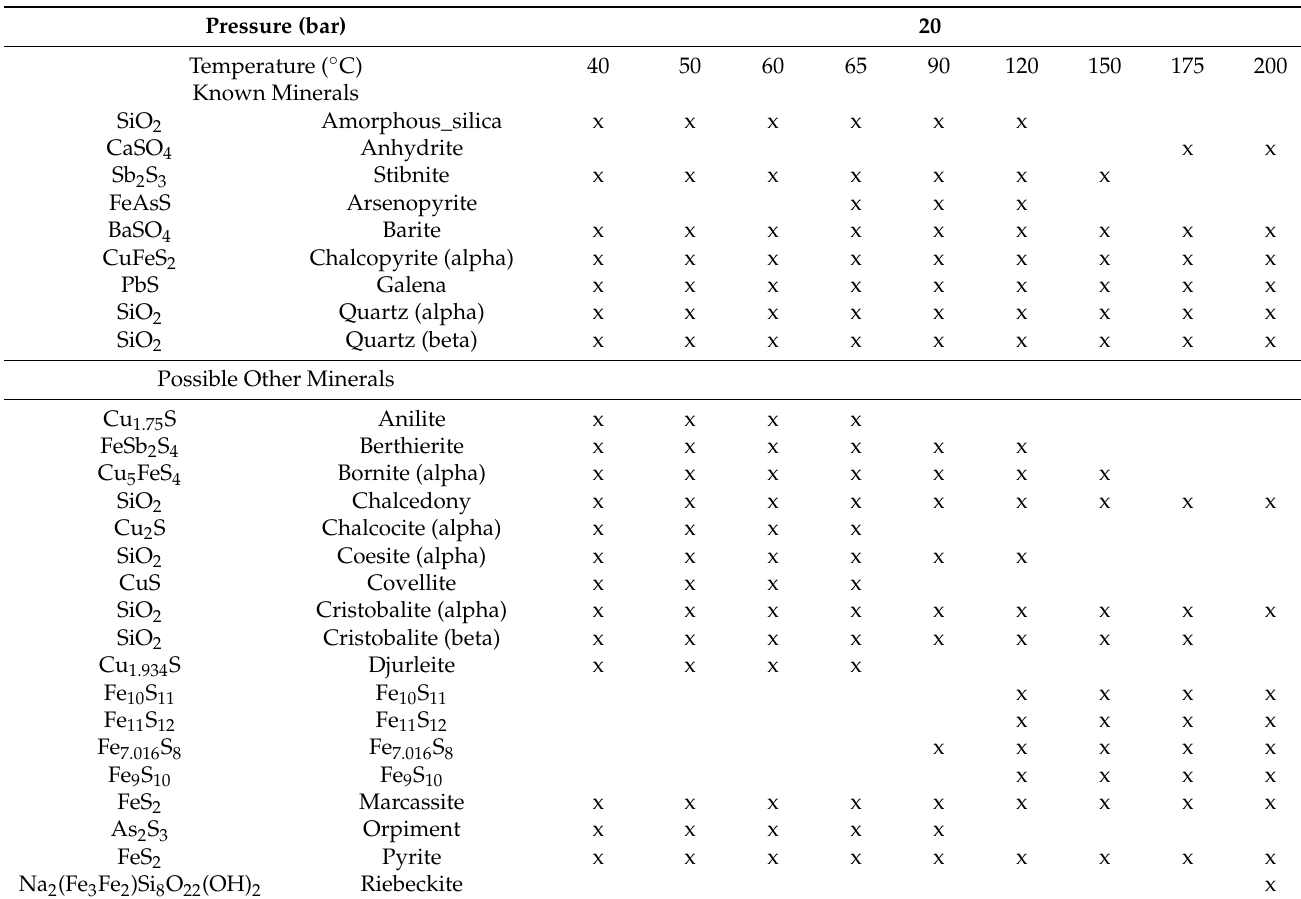
Table 9. Presence of potential minerals at the set range of temperature according to saturation index. Pressure (bar) Known Minerals